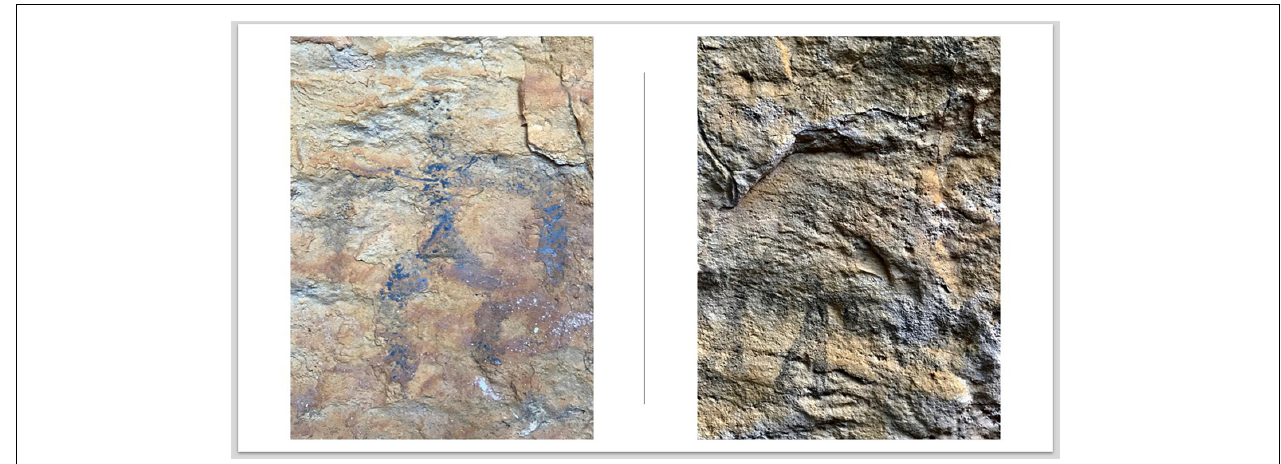
FIGURE 7 | Possible anthropomorph (left) and human pyramid (right) figures on northern wall at Anjohimpaty Rock Shelter.